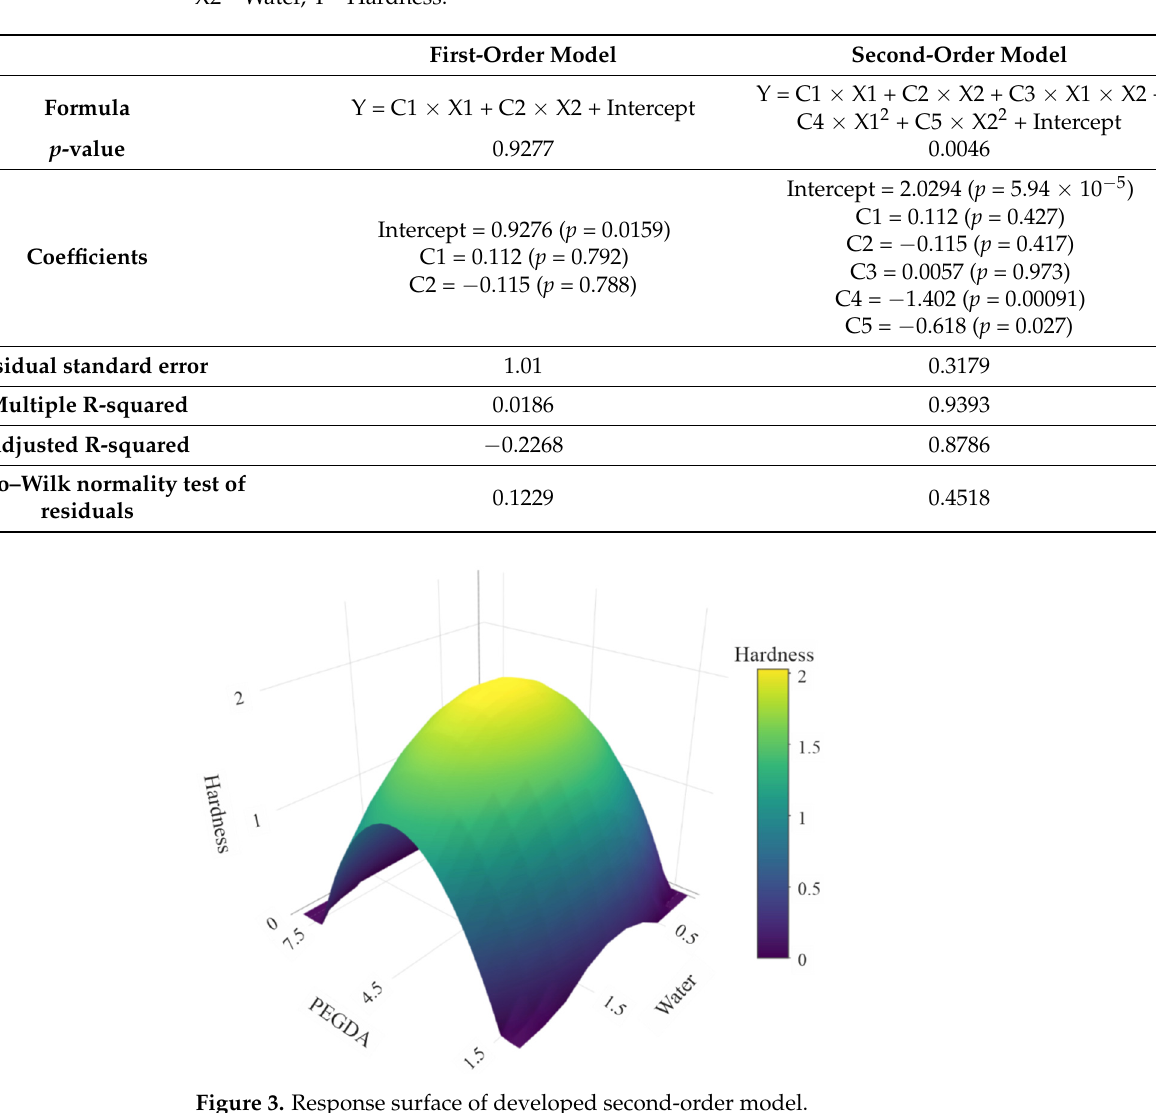
Figure 3. Response surface of developed second-order